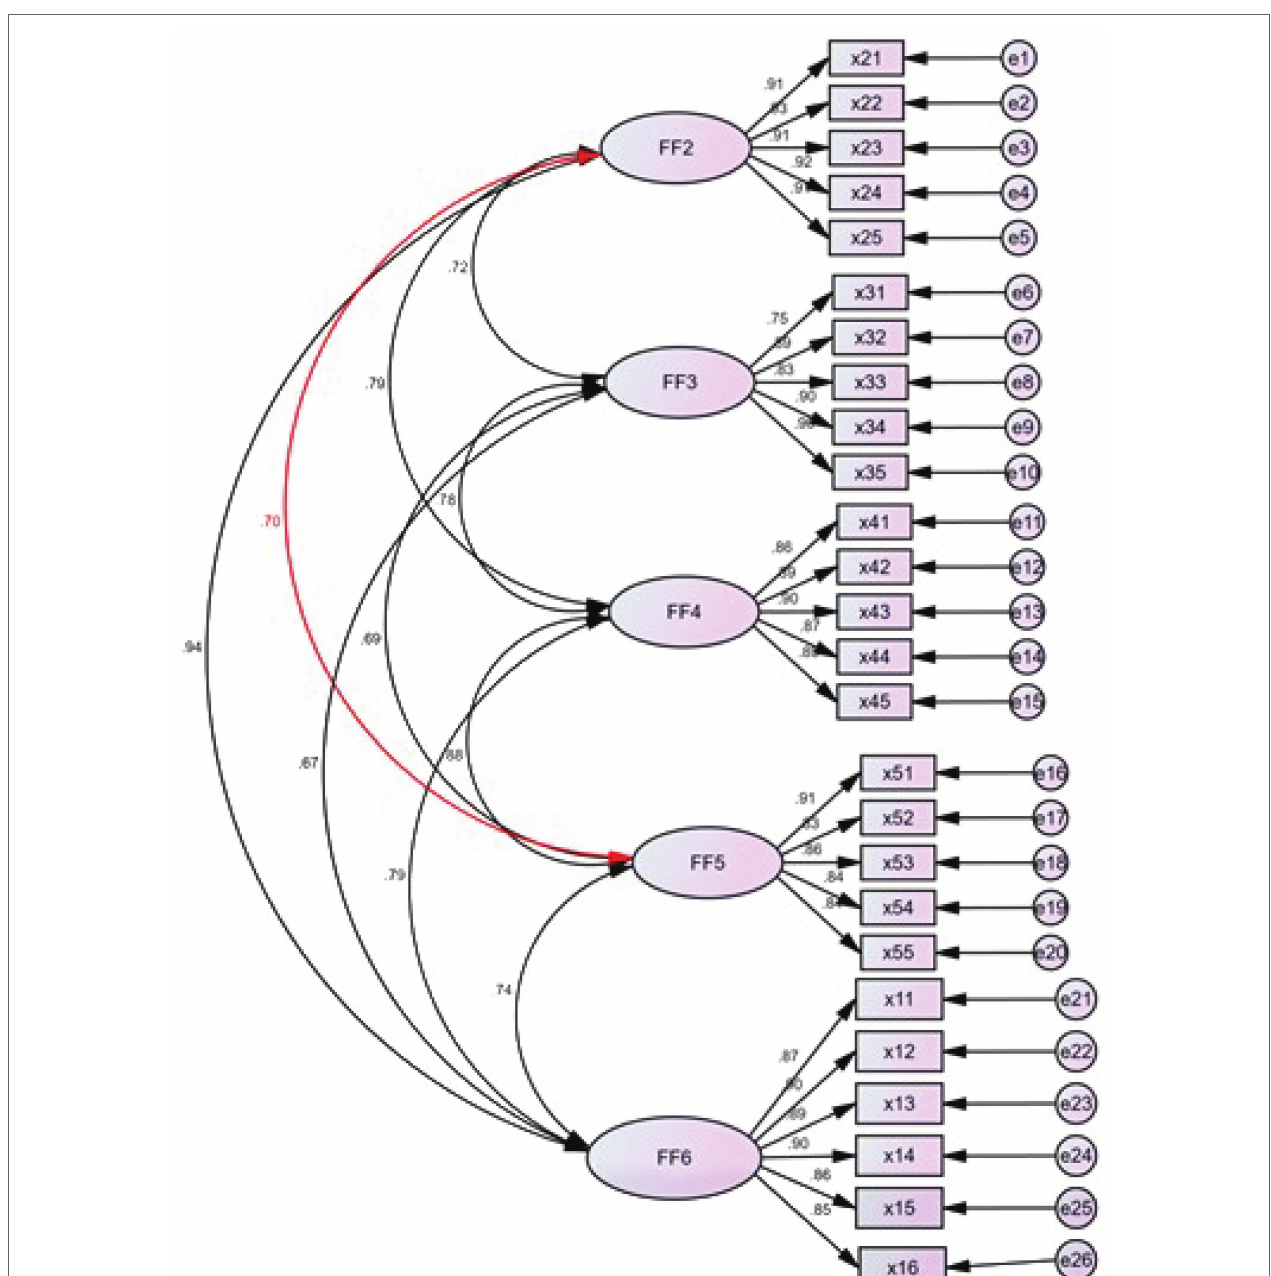
FIGURE 3 | The structural equation path analysis of the model.